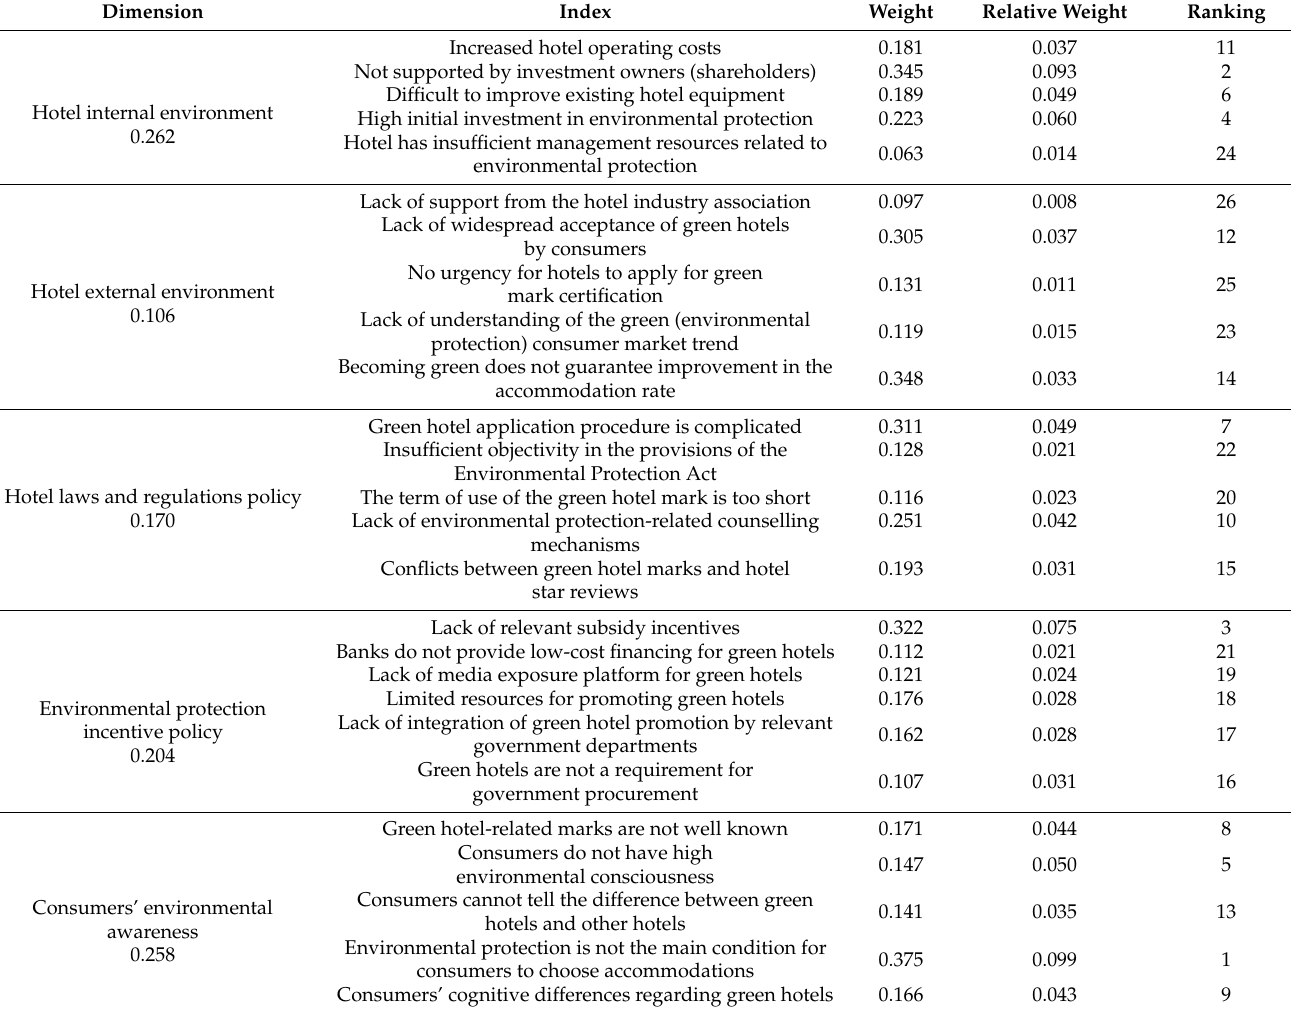
Table 3. Analysis of hindering indices of application for green hotel certification considered by scholars and experts. Dimension Index